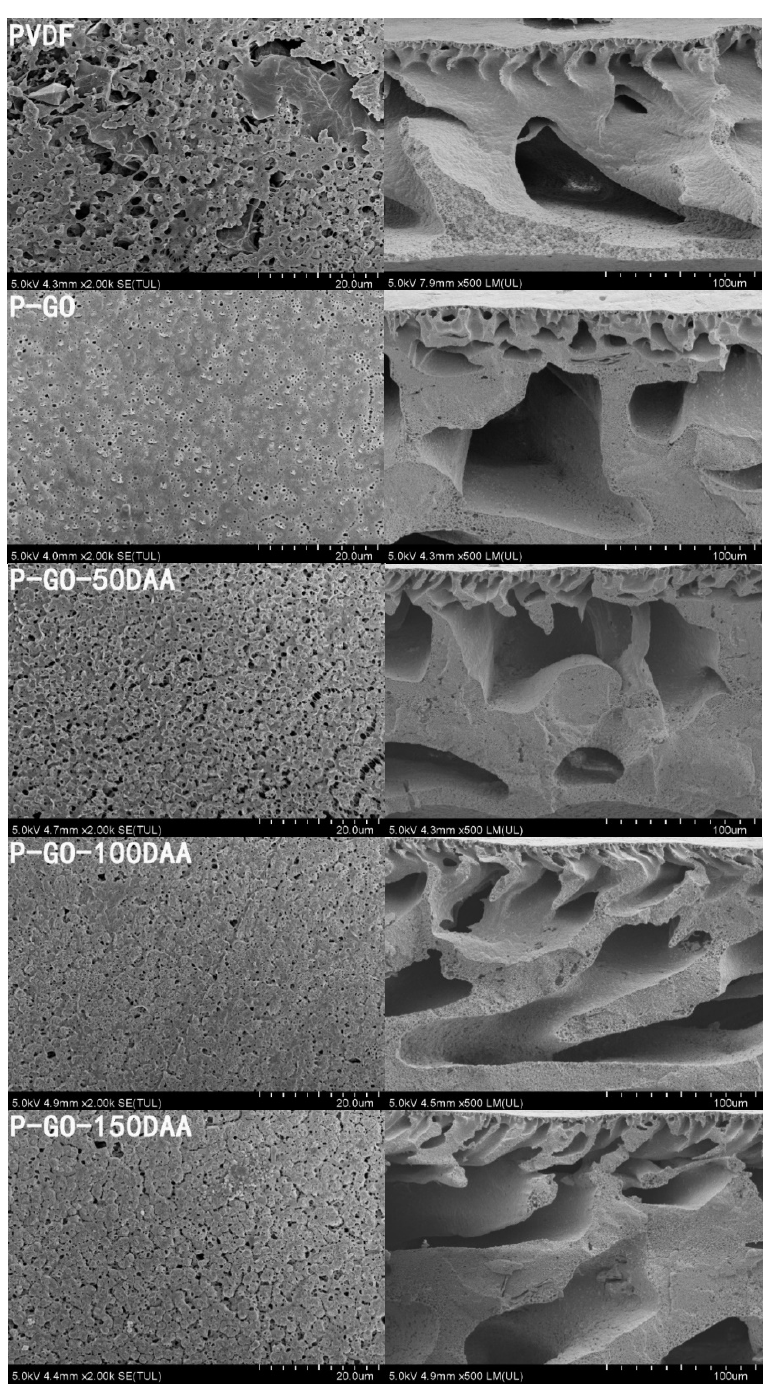
Figure 5. SEM images of the surface and cross-sectional morphologies of different membranes.